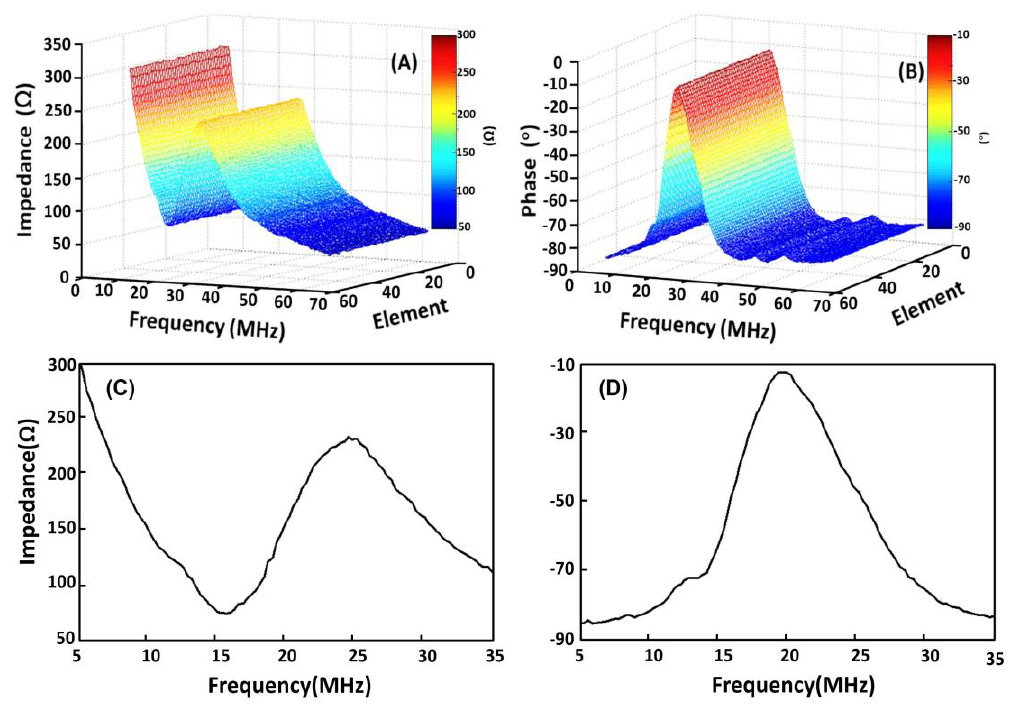
Figure 4. ( A ) Electrical impedance magnitude and ( B ) phase as a function of frequency for 48 elements. ( C ) Electrical impedance magnitude and ( D ) phase as a function of frequency for the 24th element.